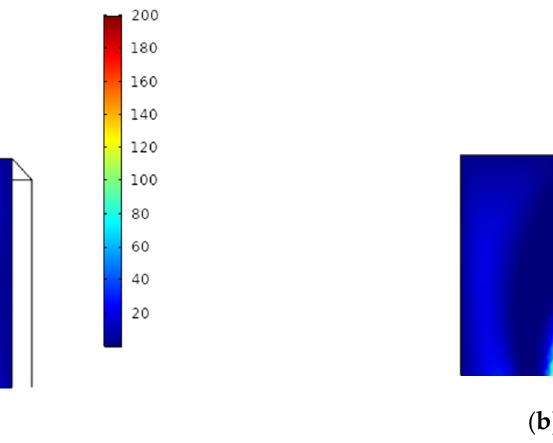
Figure 14. Comparison between turbulent viscosity ratio plots at the outlet of the leftmost fuel inlet pipe zone using ( a ) mesh 2 in model 9, and ( b ) mesh 3 in study 8.